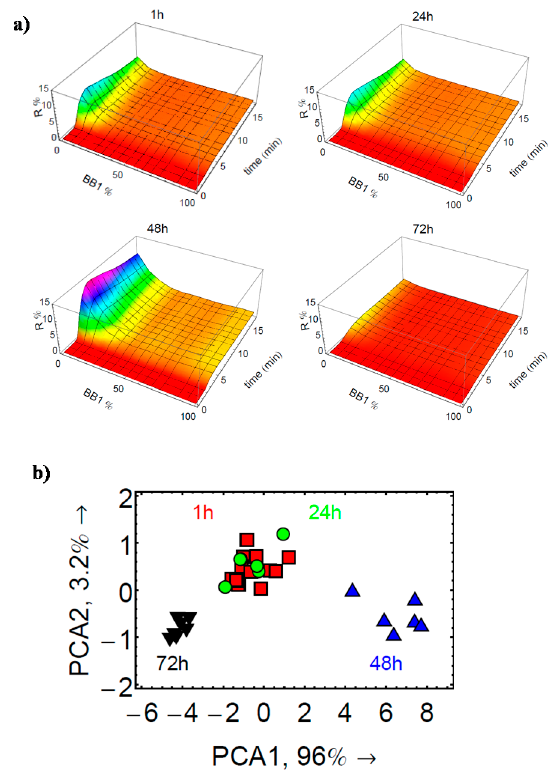
Figure 10. Monitoring spoilage of milk by the eTs: ( a ) 3D CELs of the milk sample in the 1st, 24th, 48th, and 72nd h after opening; ( b ) PCA score plot derived from the data obtained using these milk samples. Reprinted from [29].